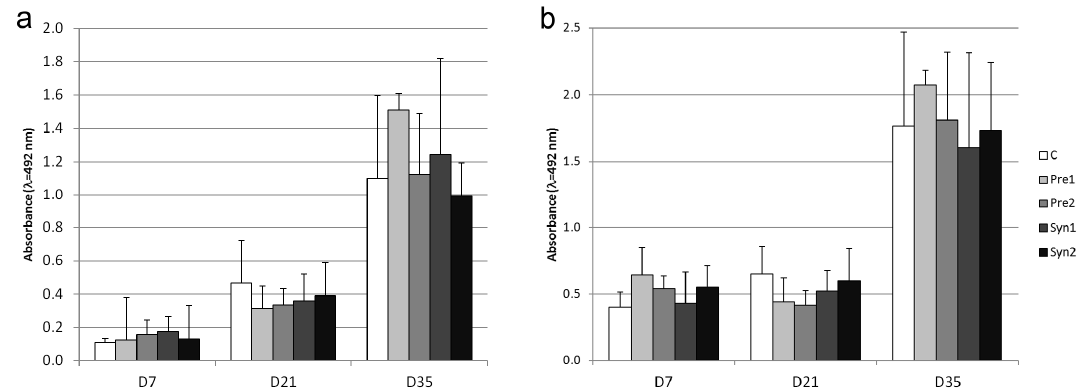
Figure 4. Serum anti-dextran IgM ( a ) and anti-dextran IgG ( b ) antibody level (mean ± SD) in